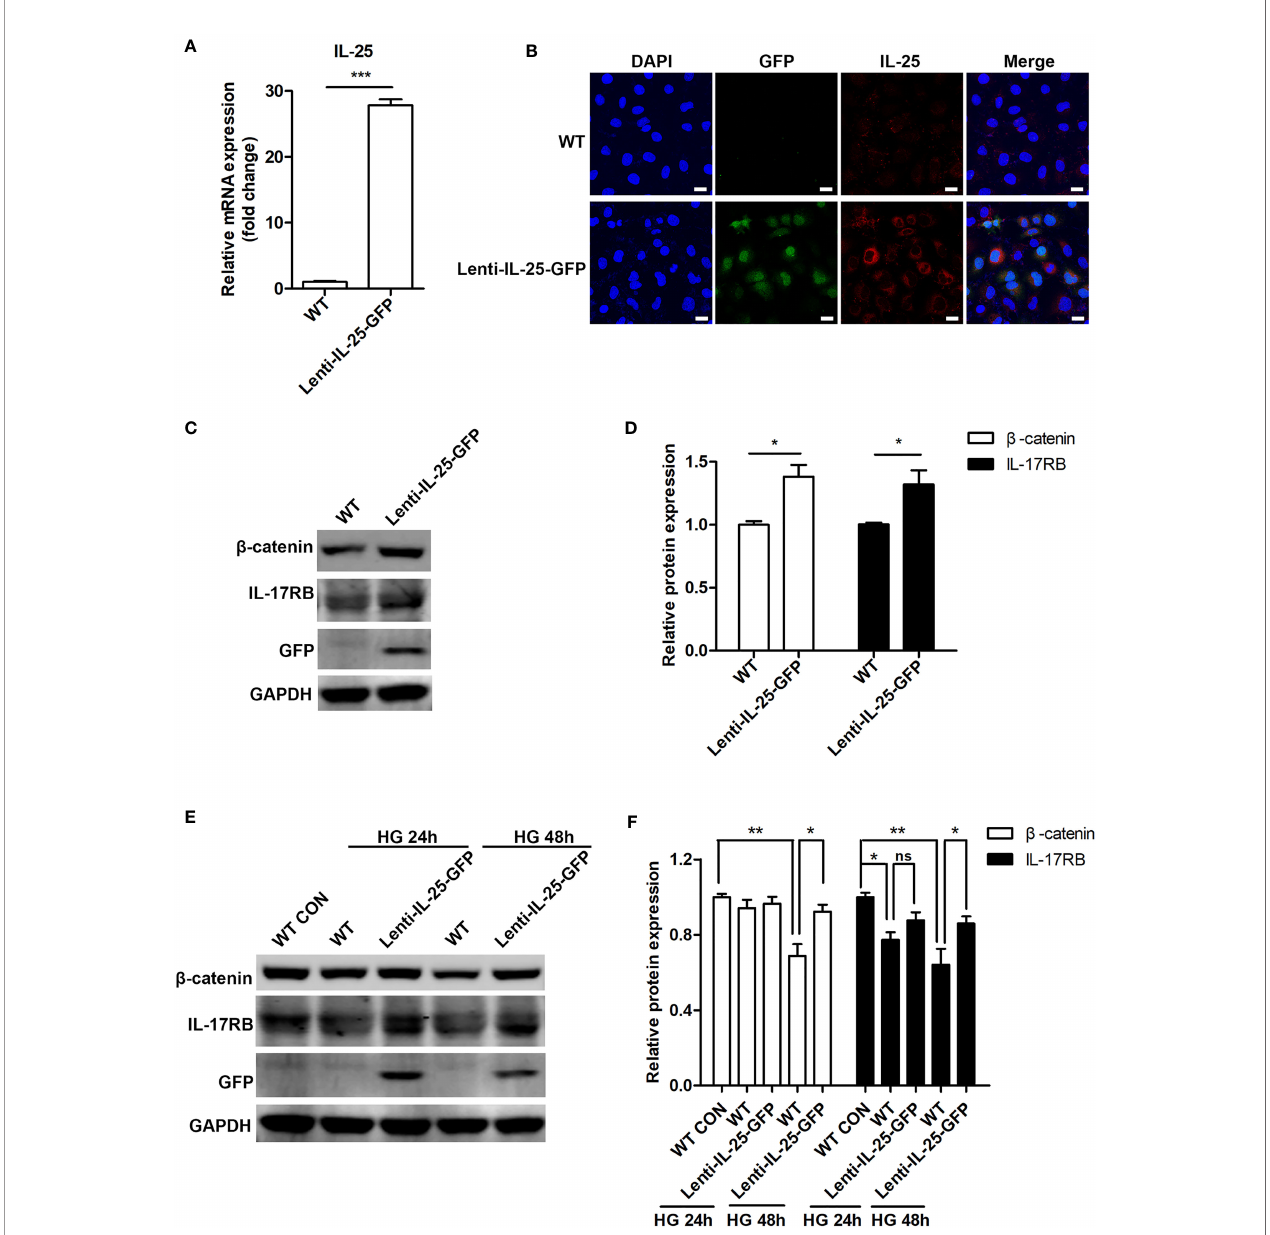
FIGURE 7 | Endogenous overexpression of IL-25 activates Wnt/ b -catenin pathway. HUVECs that stably overexpress IL-25 (Lenti-IL-25-GFP-HUVECs) were constructed by using a lentiviral expression vector of human interleukin 25 with the unfused CopGFP protein at the C-terminus (Lenti-IL-25-GFP). The overexpression of IL-25 was veri fi ed by q-PCR and immuno fl uorescent staining assays. (A) Relative IL-25 mRNA expression in wild type (WT) and Lenti-IL-25-GFP-HUVECs (n = 3). (B) Immuno fl uorescent staining images of IL-25 (red), GFP (green) and DAPI (blue) in wild type (WT) and Lenti-IL-25-GFP-HUVECs. Scale bars, 20 m m. (C, D) Western blotting analysis of b -catenin and IL-17RB in WT and Lenti-IL-25-GFP-HUVECs and their quanti fi cation under normal glucose conditions (n = 3). (E, F) Western blotting analysis of b -catenin and IL-17RB in WT and Lenti-IL-25-GFP-HUVECs after exposure to high glucose conditions for 24 and 48 h and their quanti fi cation (n = 3). * P < 0.05, ** P < 0.01, *** P < 0.001. ns, no signi fi